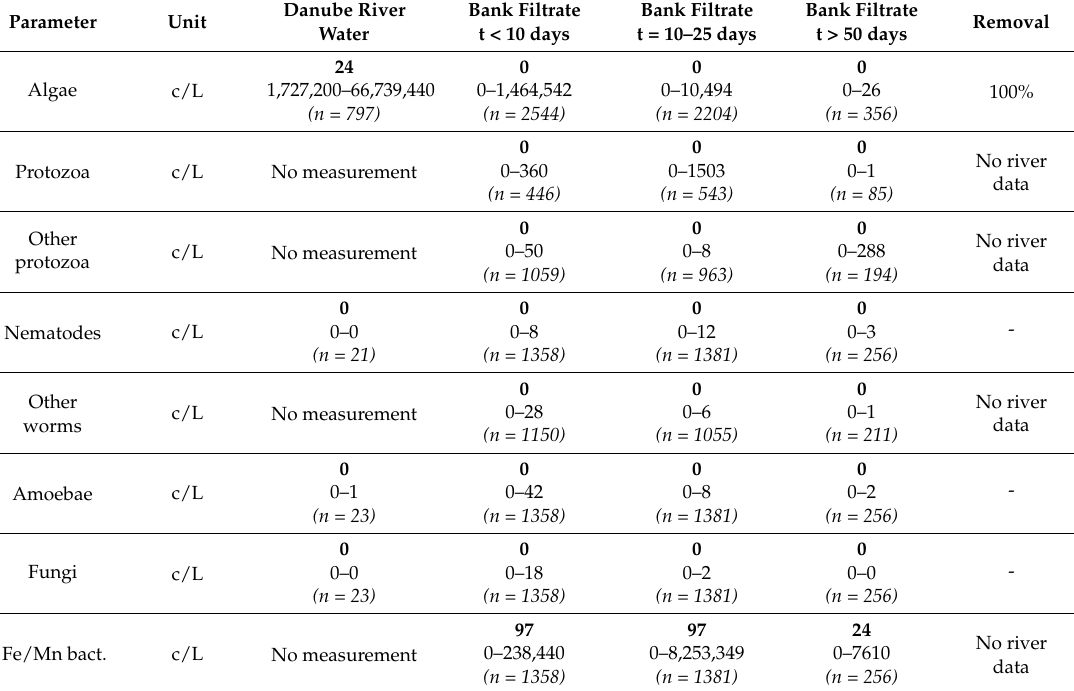
Table 6. Biological parameters, median (min–max), Danube River water and bank filtrate with different travel time (t),